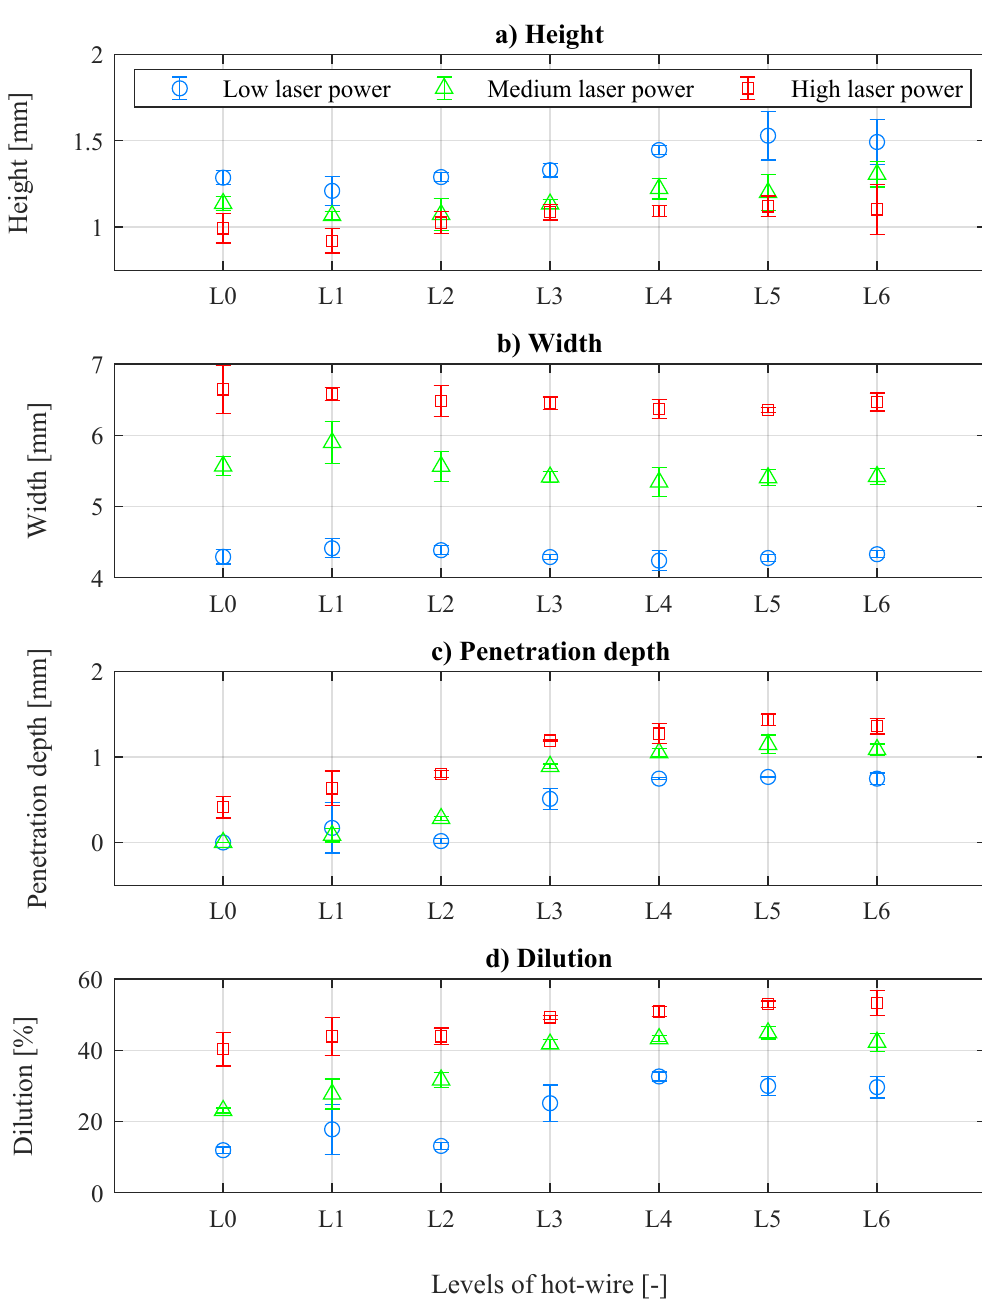
Figure 9. The average values of measured geometrical features of the beads: ( a ) height, ( b ) width, ( c ) penetration depth, ( d )